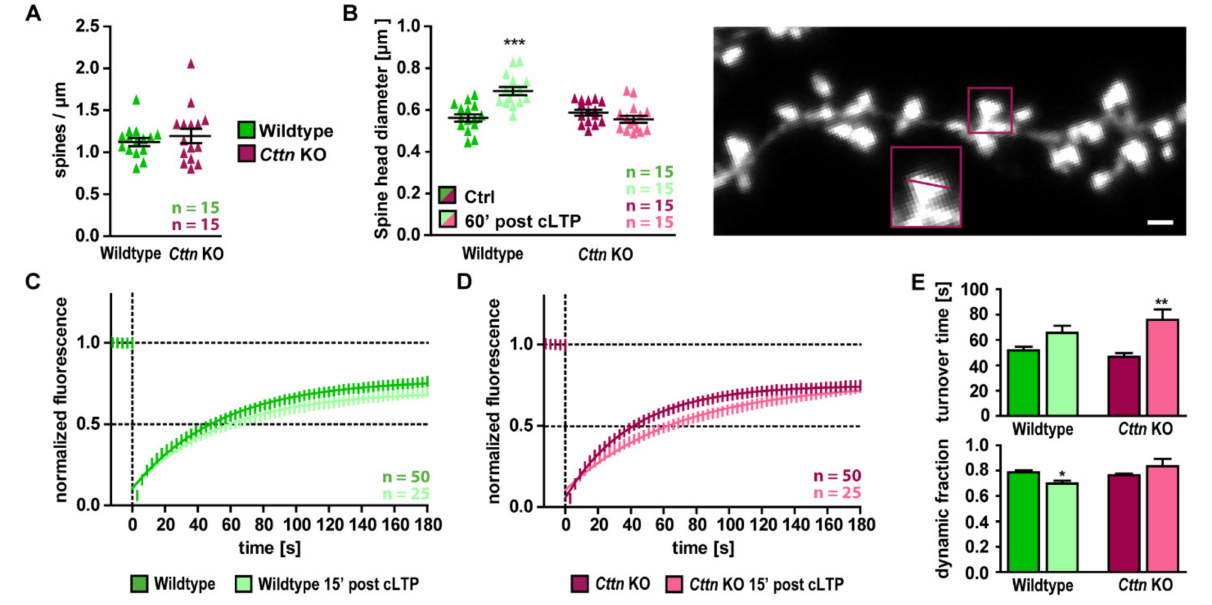
Figure 4. Structural plasticity is completely absent in Cttn-deficient hippocampal neurons. ( A ) Analysis of dendritic spine density of hippocampal WT and Cttn -KO neurons. n = number of dendrites analyzed. ( B ) Analysis of the average dendritic spine head diameter under basal conditions as well as 60 min after induction of chemically induced NMDAR- mediated long-term potentiation (cLTP). Note that structural plasticity (i.e., growth of dendritic spine head diameter) is completely missing in Cttn-deficient hippocampal neurons. Representative image depicts maximum intensity projection image of a healthy individual dendritic segment and an example of a dendritic spine head diameter analysis. n = number of dendrites analyzed. Scale bar = 1 µ m. ( C , D ) Recovery curves (EGFP-ß-actin) of individual dendritic spines from (C) WT and (D) Cttn -KO hippocampal neurons under baseline conditions as well as in the first 15 min after chemical induction of LTP. ( E ) Quantification of the turnover time and the fraction of dynamic actin (the amount of actin the fluorescence of which recovered in the time period of 180 s after the photobleach) under baseline conditions as well as in the first 15 min after chemical induction of LTP. n = number of dendritic spines analyzed. Data information: Statistic tests used: For normal distribution of data: Kolmogorov-Smirnov Test, Parametric Tests: Two-Way ANOVA and Sidak’s Multiple Comparisons, Non-Parametric Tests: Kruskal-Wallis Test and Dunn’s test; data depicted as means ± SEM, detailed information on p values as well as statistical tests is depicted in Table S1; significances are indicated by * p value < 0.05, ** p value < 0.01 and *** p value <